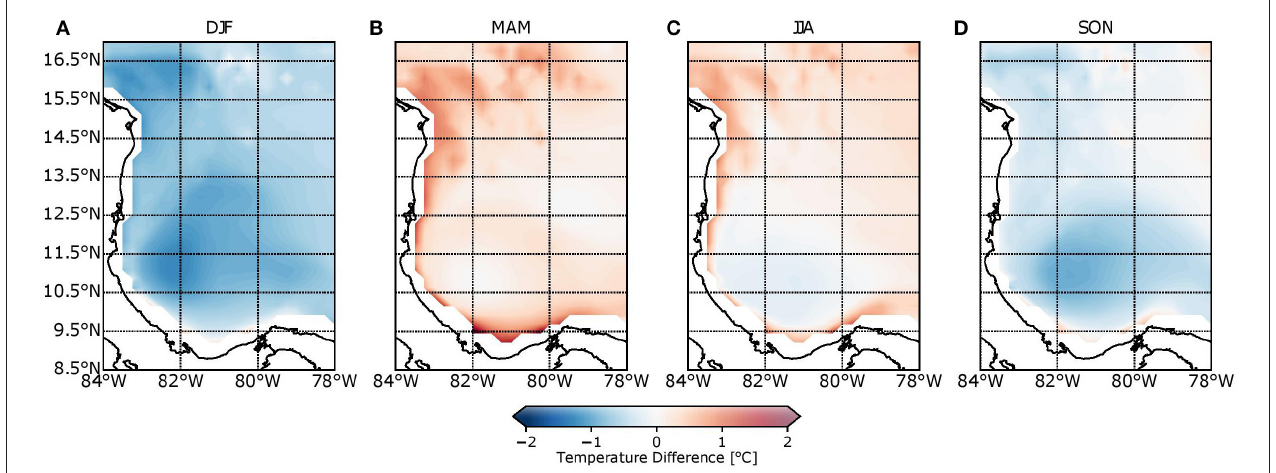
FIGURE 5 | Seasonal temperature difference between model and REYNOLDS data for (A) December–January–February, (B) March–April–May, (C) June–July–August, and (D) September–October–November. Red coloration associated with temperature overestimation, while blue coloration is associated with its underestimation.